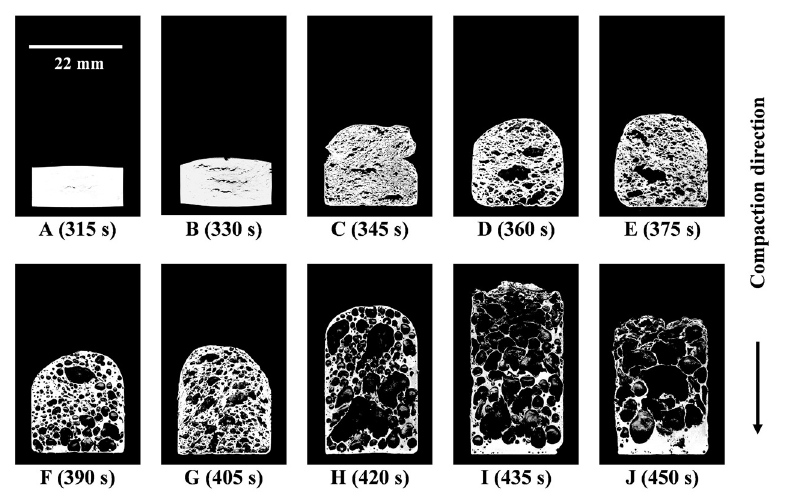
Figure 2. Macrographs showing the internal structure of foams heated for various times.